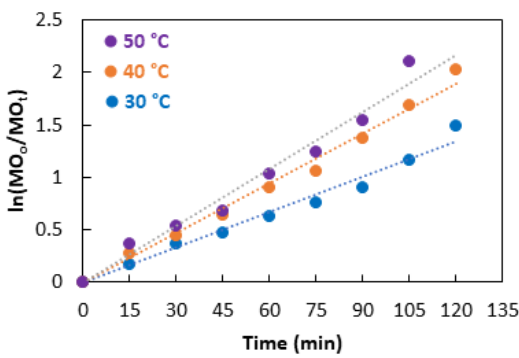
O catalyzed 3 4